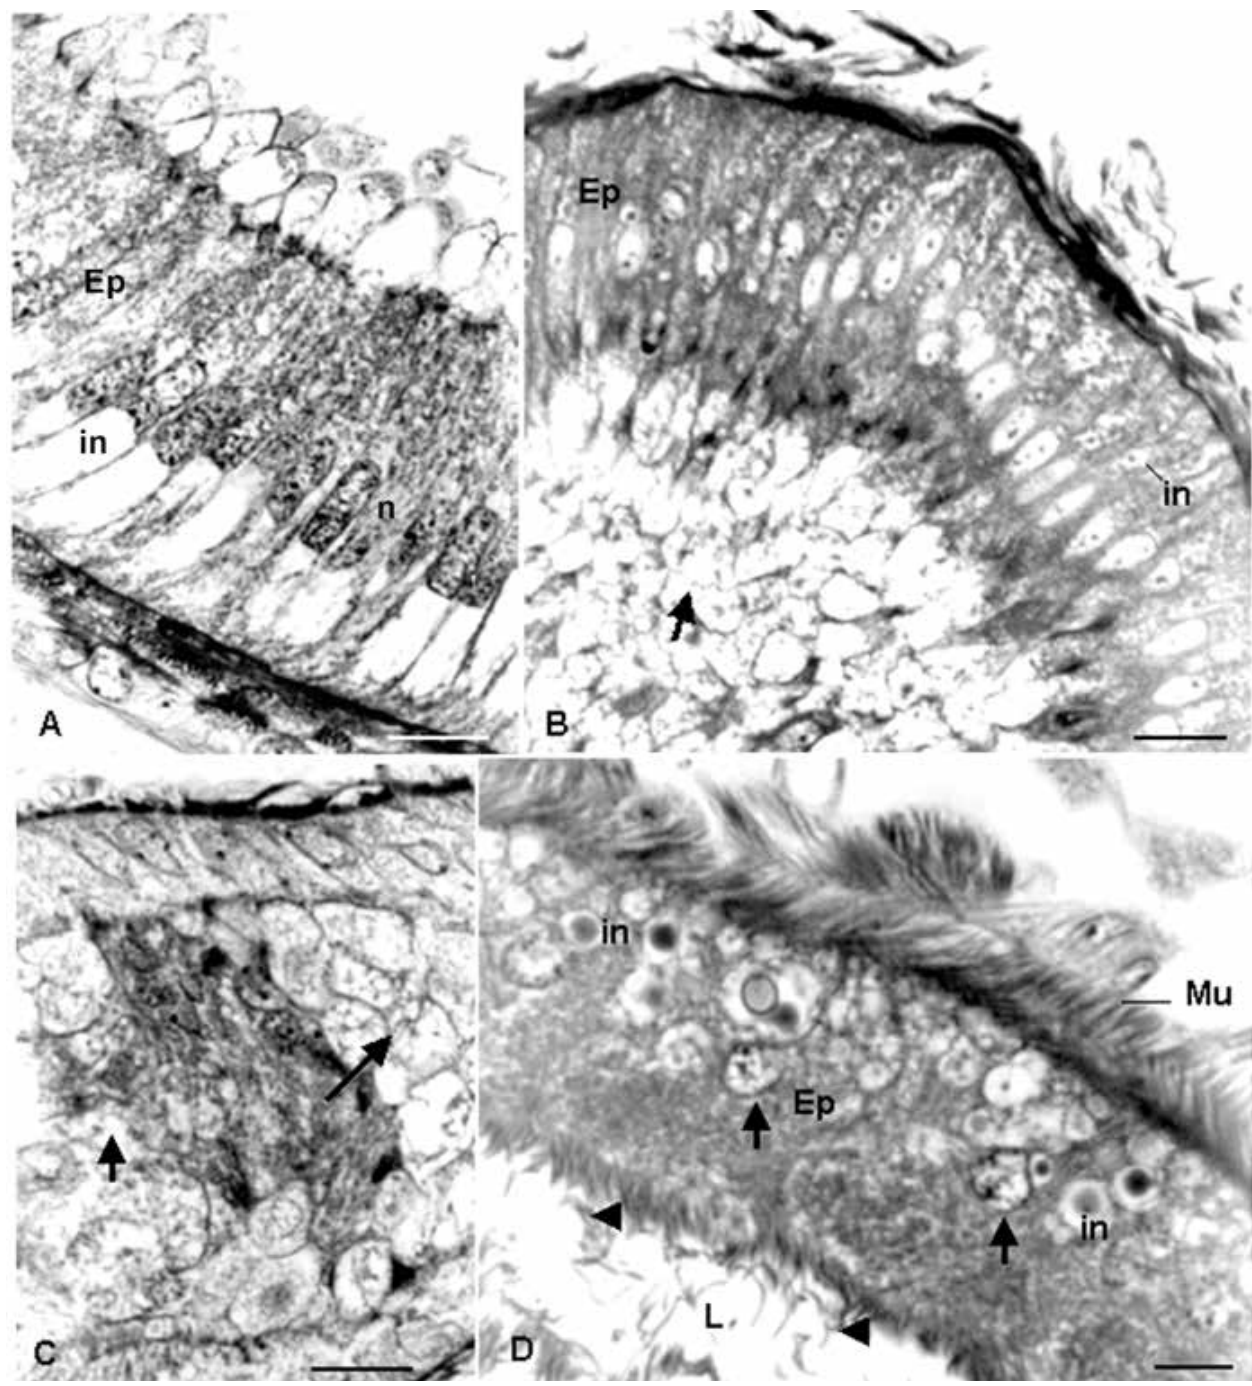
Fig 2. Light micrographs in transverse sections of the seminal vesicles and post-vesicular vasa deferentia of Scaptotrigona xanthotricha . A. Black-eyed and pigmented body pupae showing the epithelium of the seminal vesicle (Ep) with prismatic cells rich in apical vesicles, median nuclei (nu) and vesicles inclusions in the base (in). B-C. 3-day-old adult male showing vesicular inclusions (in) at the base of the epithelial cells (Ep) and secretions in the lumen (arrow) of the vasa deferentia . D. 5-day-old adult male showing cubic epithelium (Ep), with basal cell nuclei (arrow) and sperm at the apical edge of the epithelium (arrow head). Note the vesicular inclusions (in) at the base of the epithelium that is lined a muscle layer (Mu). Bars: A-C = 20µm; D =